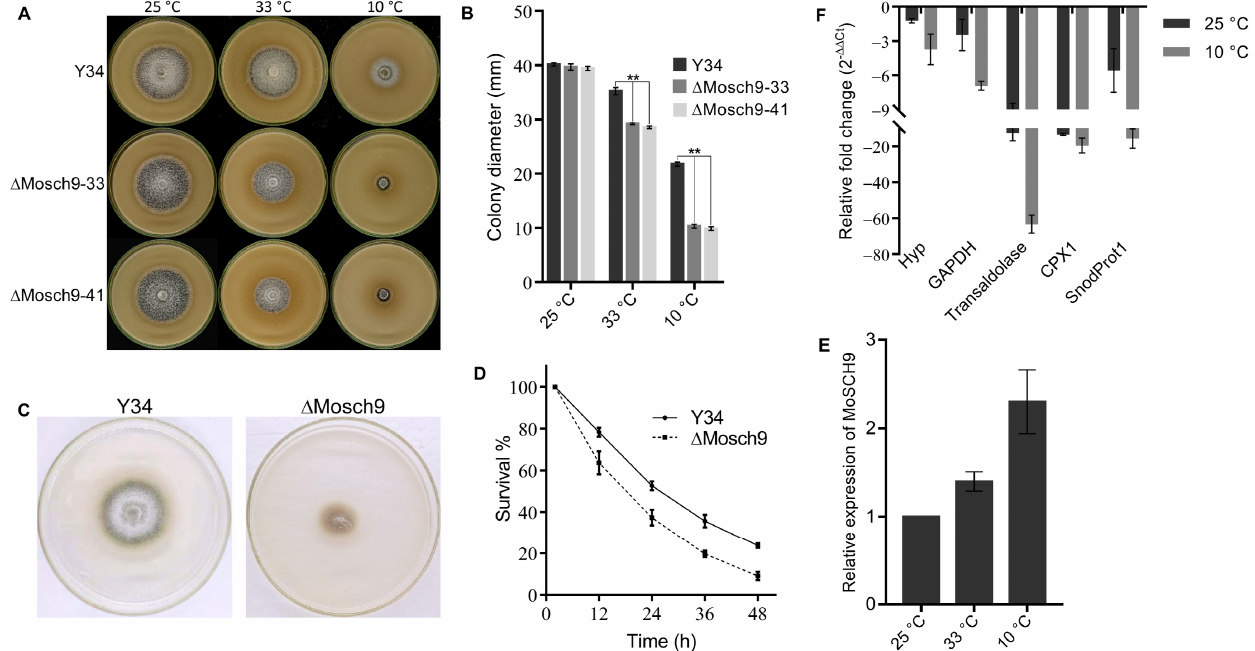
Figure 5. MoSch9 deletion affected the full morphological development of rice blast fungus under temperature stress. ( A ) Depicts the average colony growth of ∆ MoSch9 strains and wild type cultured on RBM media under high (33 ◦ C) and low temperature (10 ◦ C) stress for 10 days, taking 25 ◦ C as normal temperature. ( B ) Average growth rate of respective wild-type and mutant strains on RBM after 10 days of temperature stress. ( C ) Respective wild-type and mutant strain growth on CM medium for 5 days after − 20 ◦ C treatment. ( D ) Percentage survival rates of wild type and MoSch9 mutant’s conidia after − 20 ◦ C treatment. ( E ) Expression pattern of MoSch9 in M. oryzae under high (33 ◦ C) and low temperature (10 ◦ C) stress, taking M. oryzae growth at 25 ◦ C as control. ( F ) qRT-PCR analysis of M. oryzae cold responsive genes i.e., Hyp (Putative uncharacterized protein), GAPDH (Glyceraldehyde-3-phosphate dehydrogenase), Transaldolase, CPX1 (Catalase-peroxidase 1), and SnodProt1 in MoSch9 mutant strains at normal (25 ◦ C) and low (10 ◦ C) temperature taking wild type expression as control (unity = 1). Error bars indicate standard deviation from three independent replicates. (**) represent significant difference ( p <